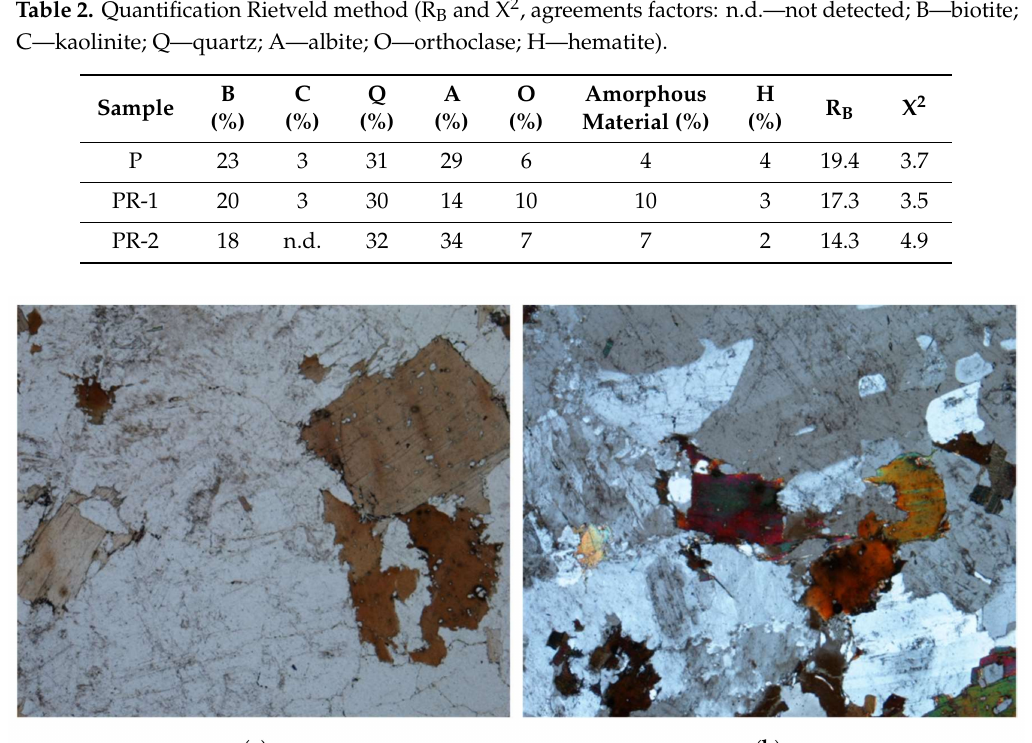
Table 2. Quantification Rietveld method (R B and X 2 , agreements factors: n.d.—not detected; B—biotite;